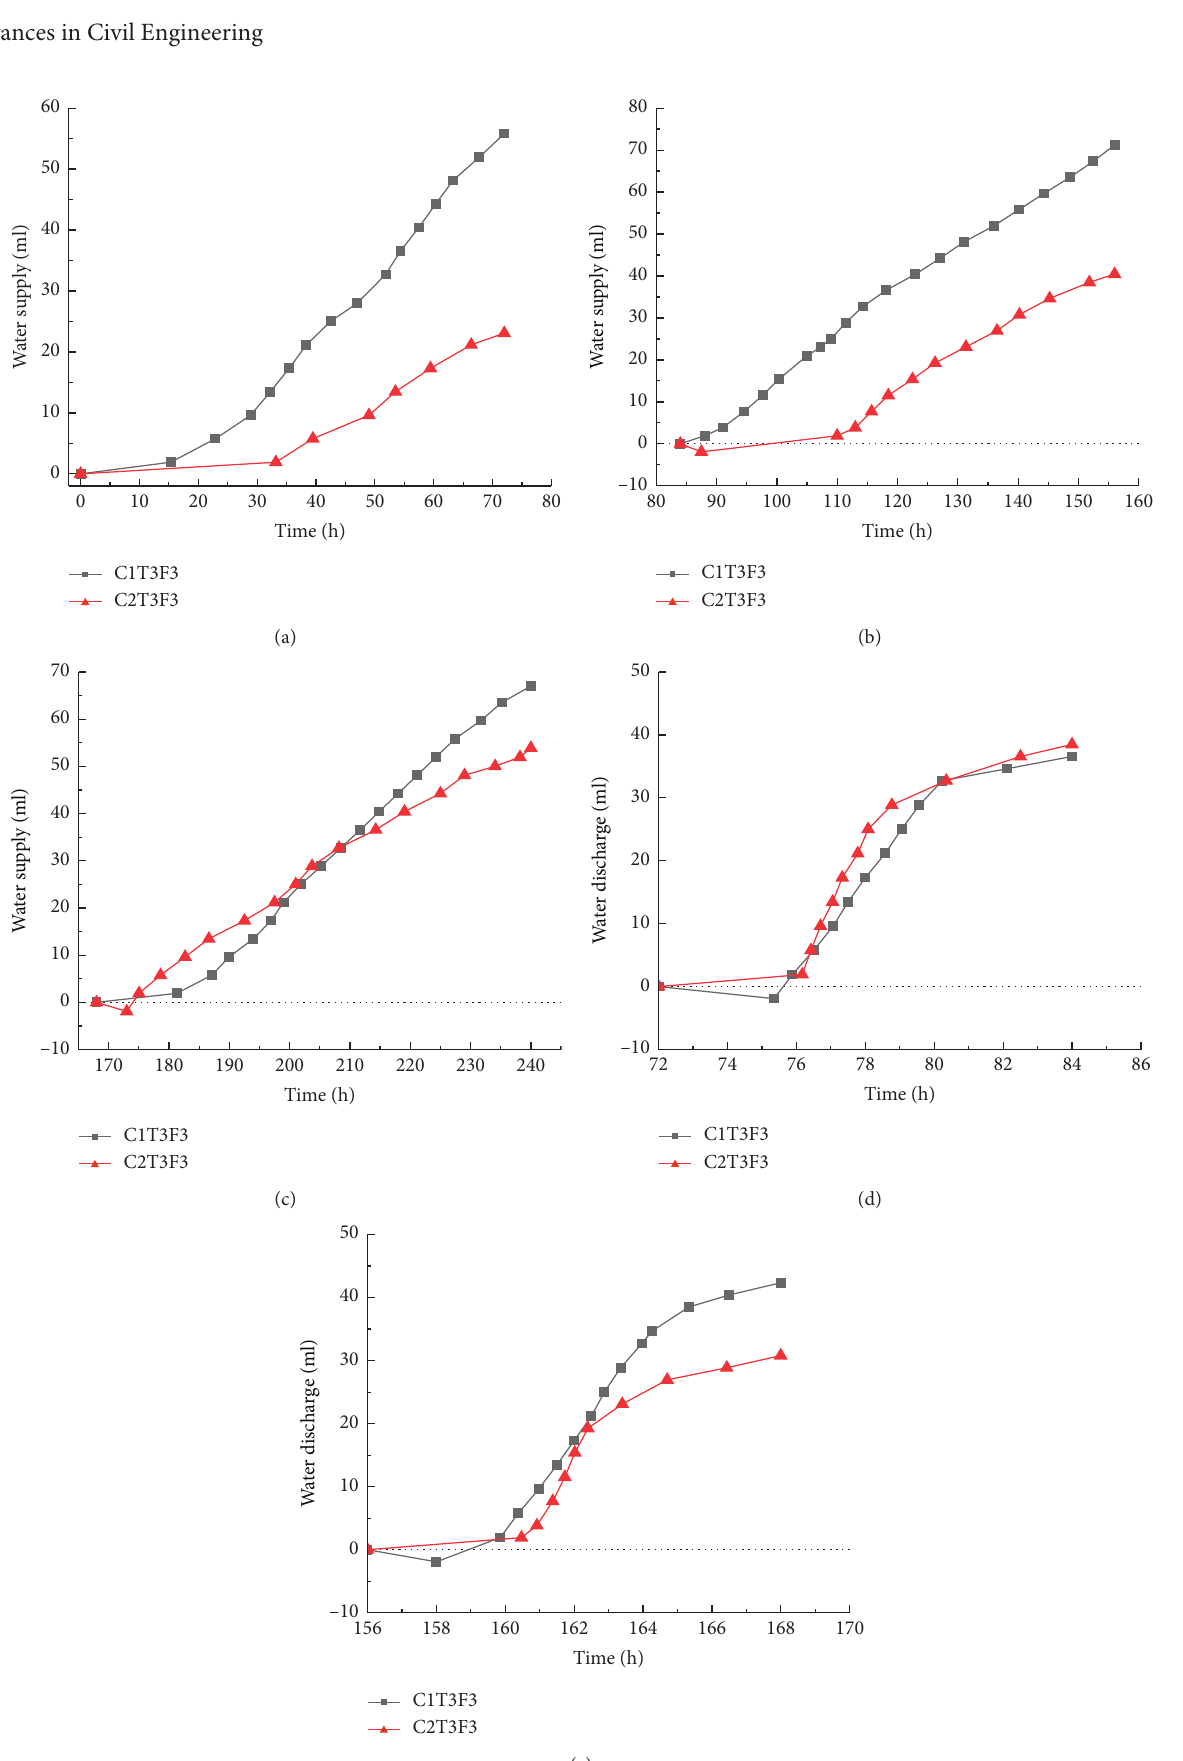
Figure 7: Comparison of water supply and discharge with different compaction levels. (a) First freezing. (b) Second freezing. (c) Third freezing. (d) First thawing. (e) Second